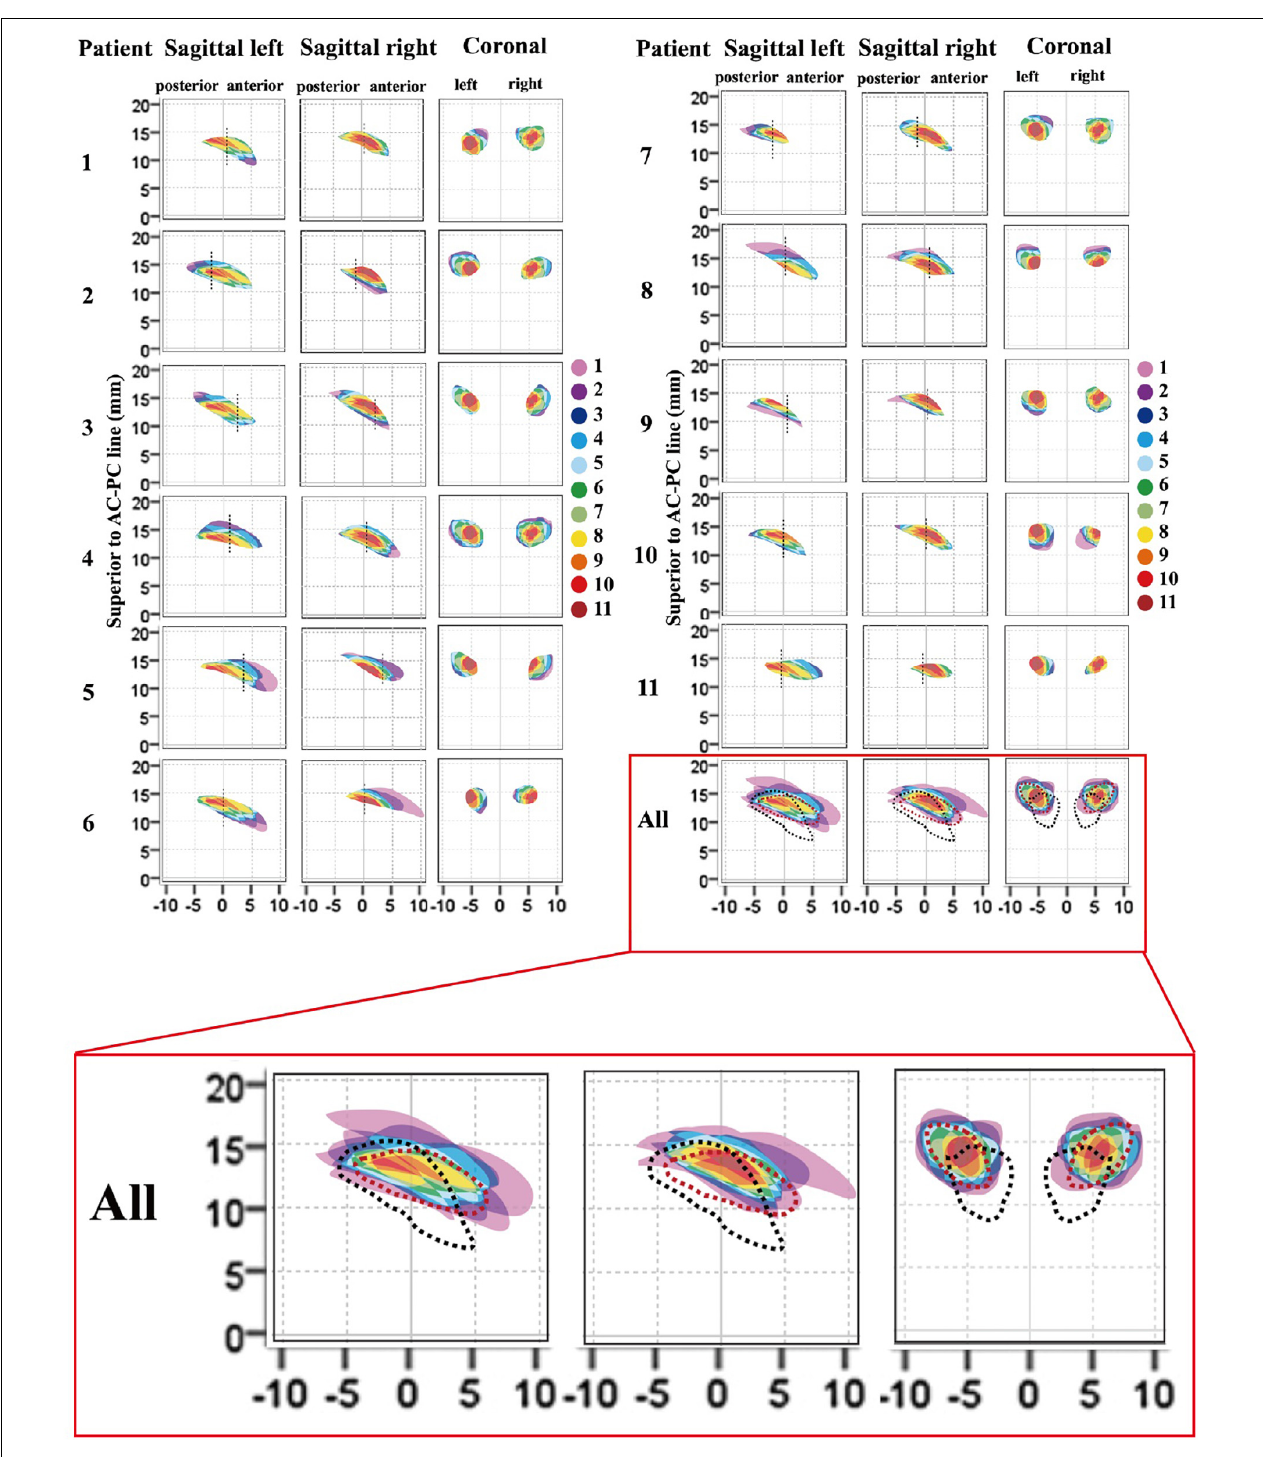
FIGURE 5 | Cross-sectional morphological variations for ANT between patients. Each individual anatomical model (1–11) relative to the whole patient group (all), and the atlas was presented in the AC–PC coordinate system. The degree of overlap (from 1 to 11) for each individual ANT model relative to the whole patient group is represented as different colors. The vertical dashed dark line in the sagittal image represents the location of the coronal ANT model in the y -axis. In the last image (all), the degree of overlap in the whole patient group is presented and the ANT models from the Schaltenbrand and Wahren atlas (dark lines) and Morel’s atlas (red lines) are delineated by dashed outlines. The results indicated that the ANTs on 3-T QSM in this group were located more anteriorly, superiorly, and laterally compared with the ANT in the Schaltenbrand and Wahren atlas. However, the locations of the ANT were more consistent with the ANT depicted in Morel’s atlas. ANT, anterior nucleus of the thalamus; AC, anterior commissure; PC, posterior commissure; QSM, quantitative susceptibility mapping.